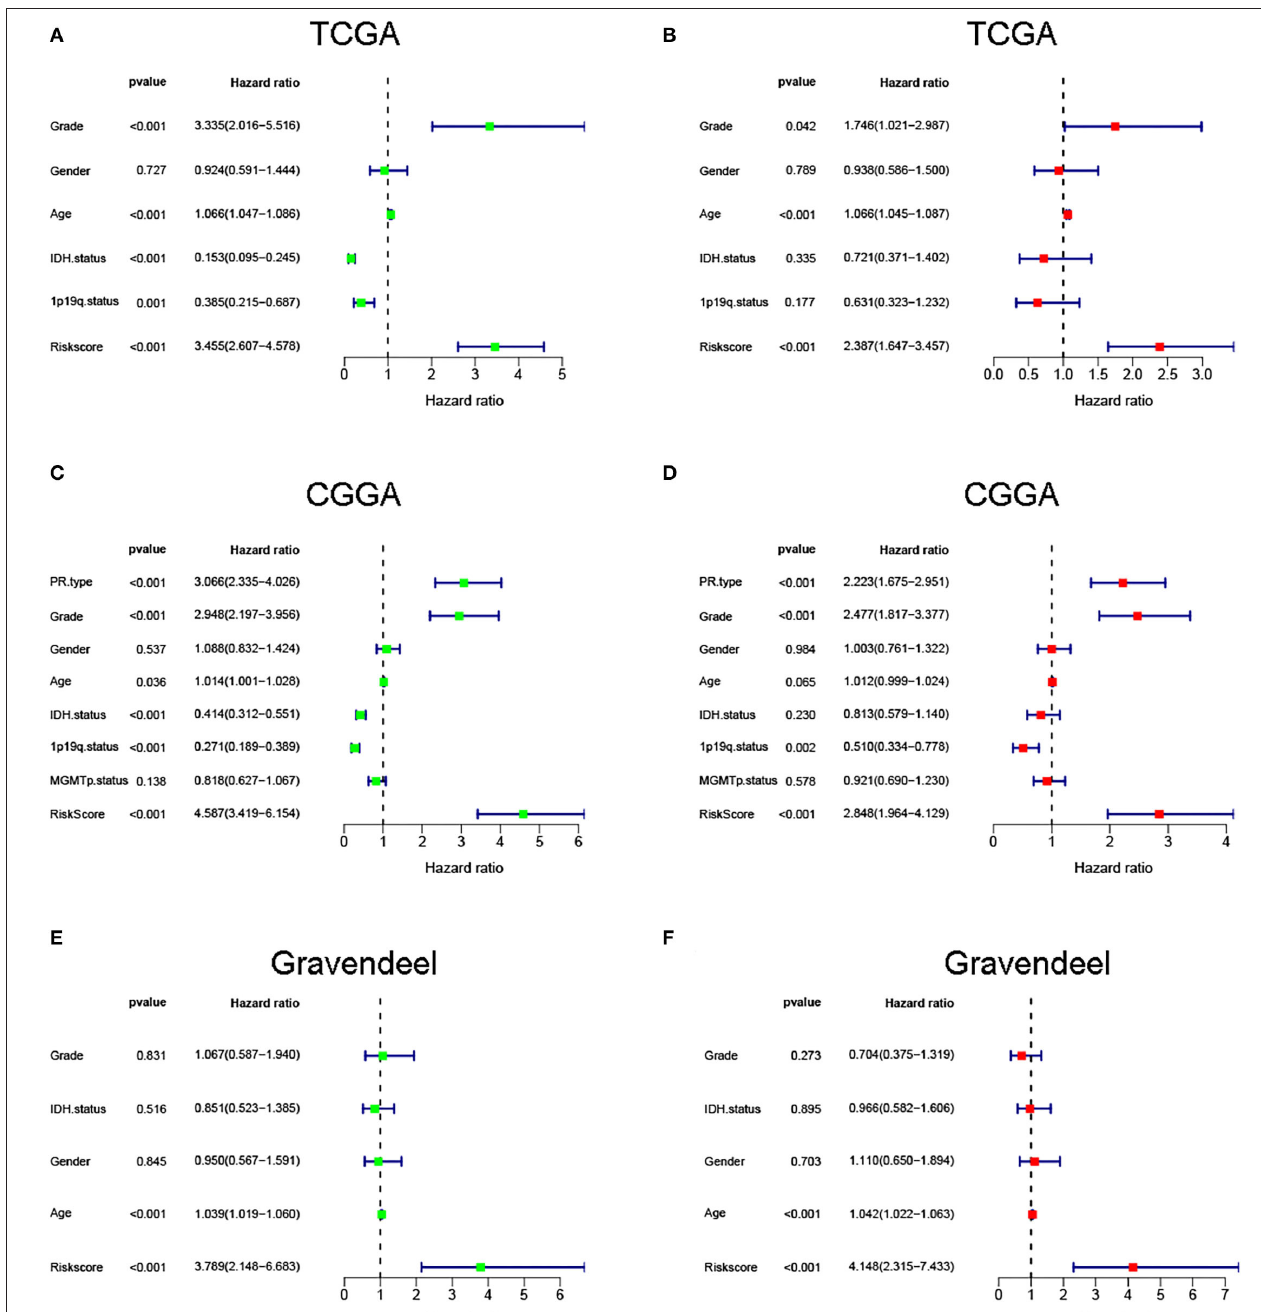
FIGURE 5 | Univariate and multivariate regression analyses were performed in (A,B) The Cancer Genome Atlas (TCGA), (C,D) Chinese Glioma Genome Atlas (CGGA), and (E,F) Gravendeel cohorts.